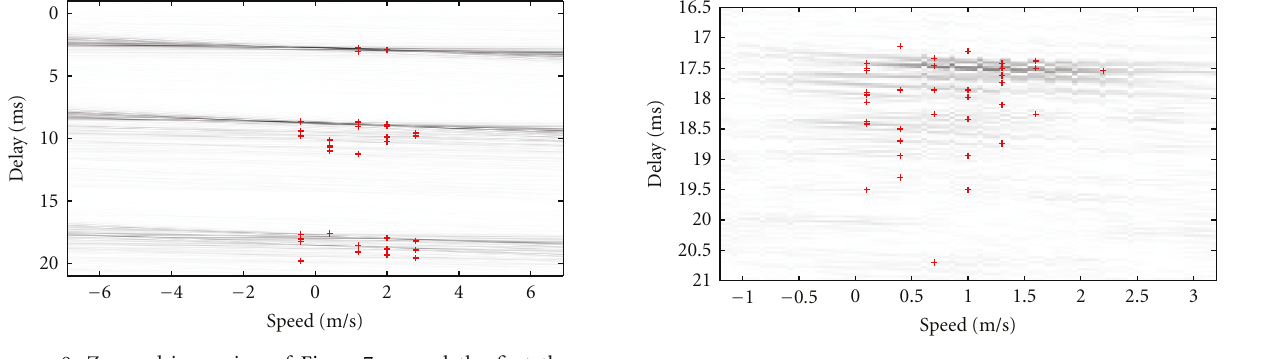
Figure 10: Zoomed-in version of Figure 9 around the third arrival path group in the wideband ambiguity function of the received OFDM signal in the KAM08 experimental data. The crosses represent the maxima detected after each MPD